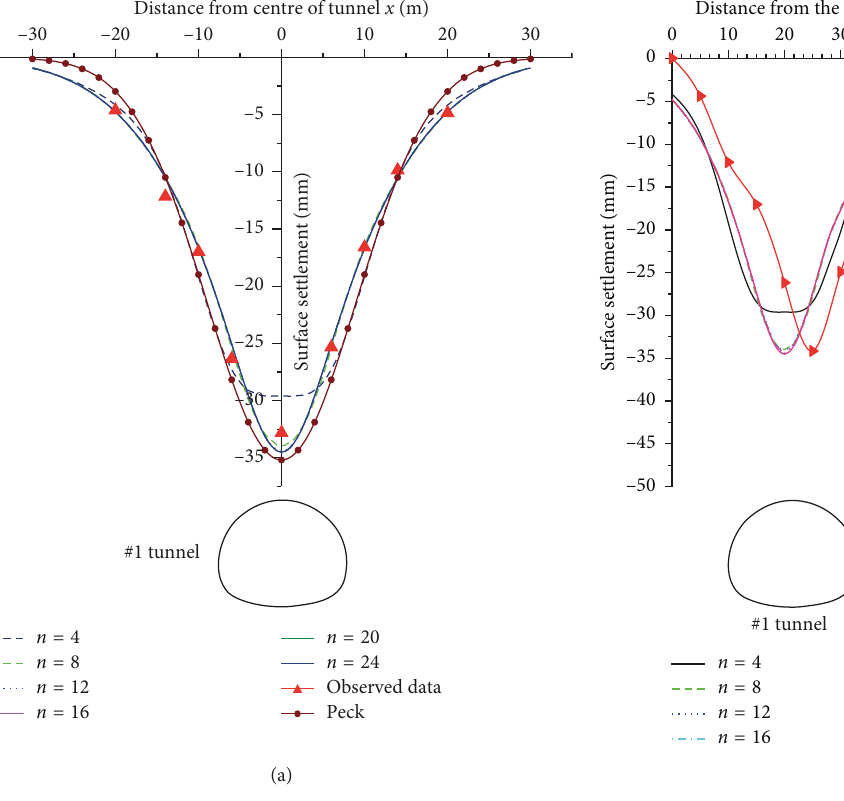
Figure 4: Surface settlement curves of different units. (a) #1 tunnel. (b) #2 tunnel. Table 1: Parameters of different settlement curves (#1